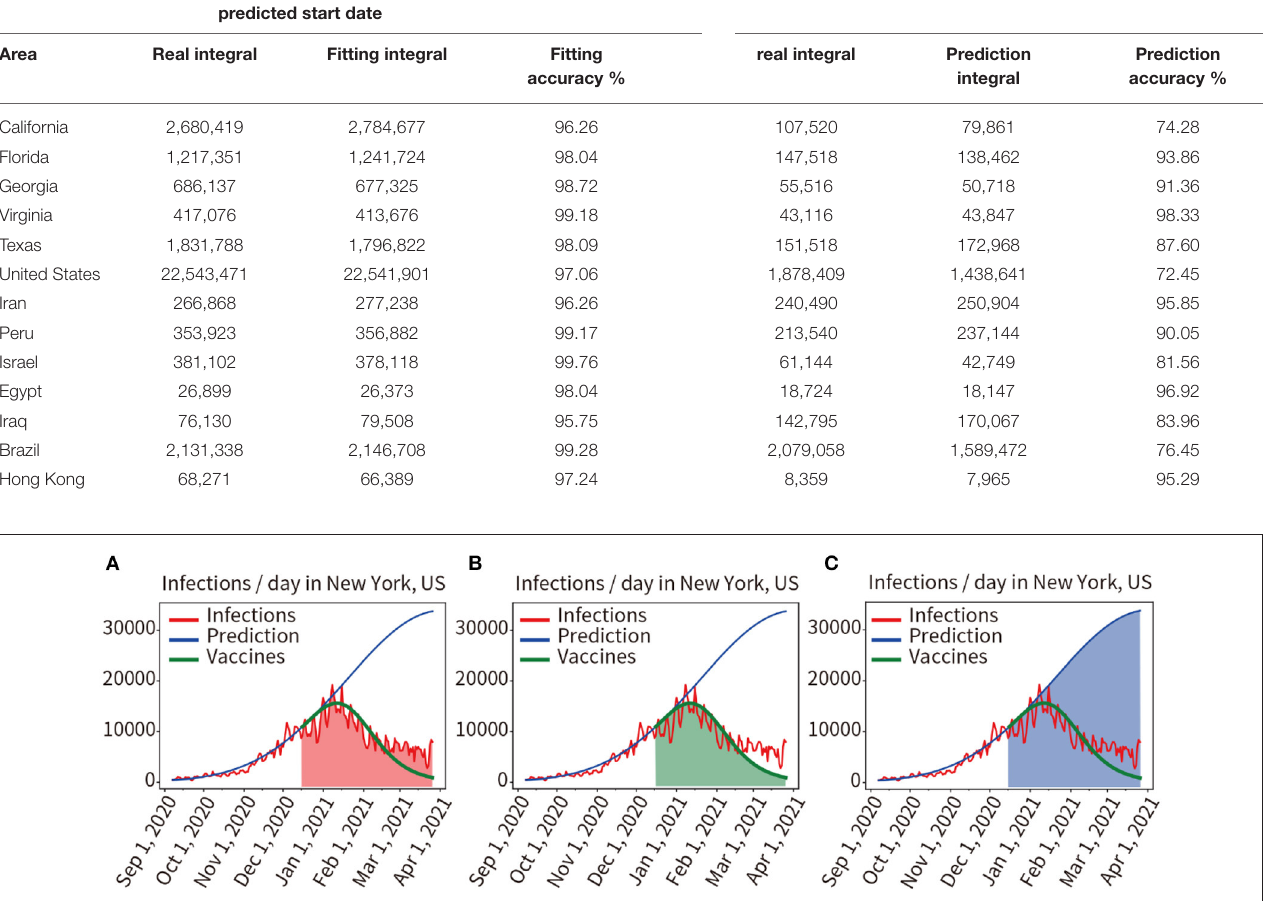
TABLE 1 | Fitting and prediction accuracy for 13 countries and regions. Results of training and fitting using the pandemic data before the predicted start date